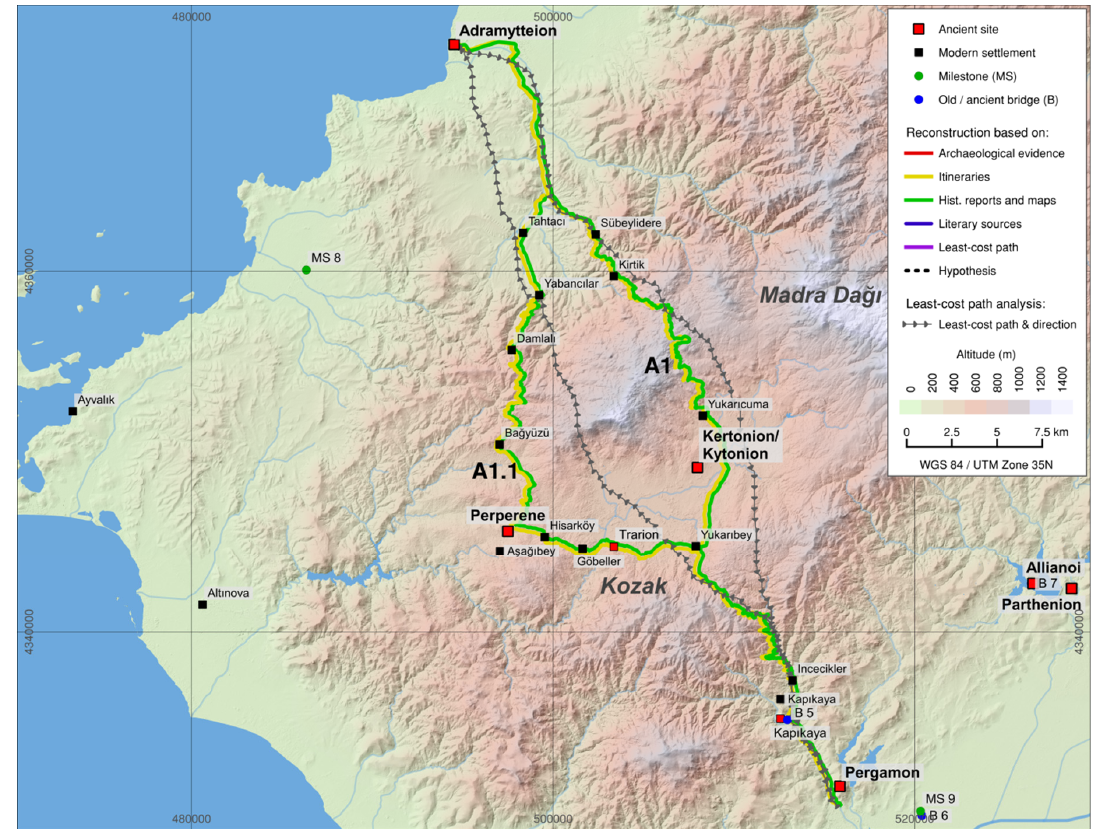
Figure 6. Calculated least-cost paths and reconstructed routes between Adramytteion and Pergamon.